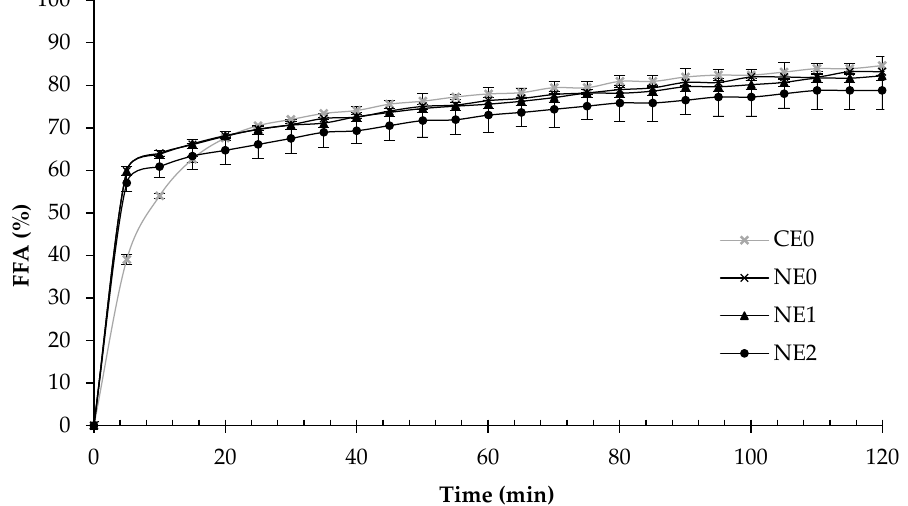
Figure 8. Free fatty acid (FFA) release during the intestinal phase of coarse emulsion and nanoemulsions with different pectin concentrations (0%, 1%, and 2%). CE0, coarse emulsion without pectin; NE0, nanoemulsion without pectin; NE1, nanoemulsion with 1% of pectin; NE2, nanoemulsion with 2% of pectin.